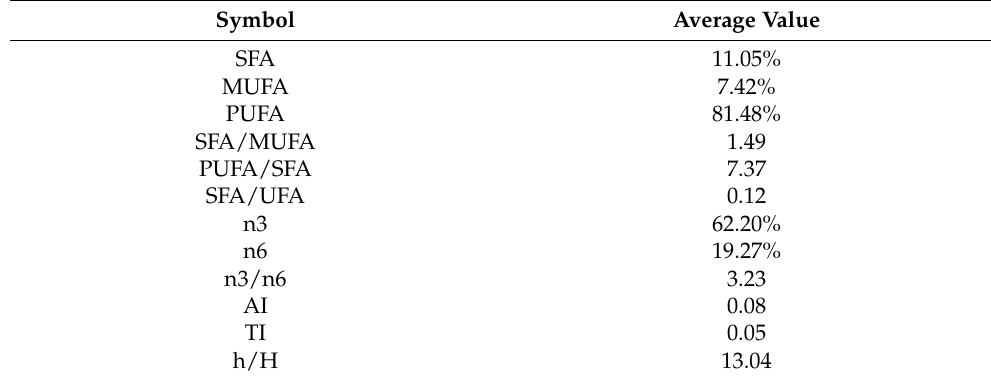
Table 2. Mean values of three replicates of fatty acid classes, ratios, and nutritional indices in Chia seed oil. Symbol Average Value SFA 11.05% MUFA 7.42% PUFA 81.48% SFA/MUFA 1.49 PUFA/SFA 7.37 SFA/UFA 0.12 n3 62.20% n6 19.27% n3/n6 3.23 AI 0.08 TI 0.05